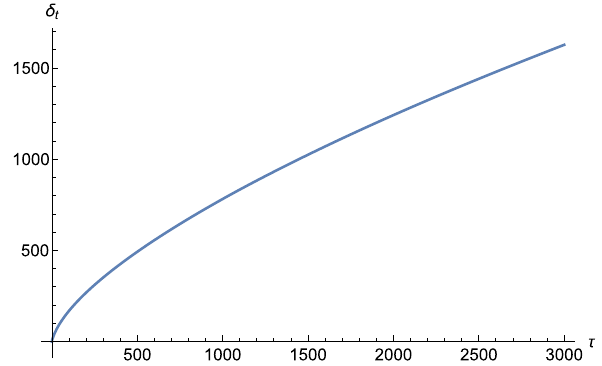
Fig. 2 Total density contrast δ t as a function of time τ = H 0 t for large wavelength with respect to Jeans’ wavelength λ 0